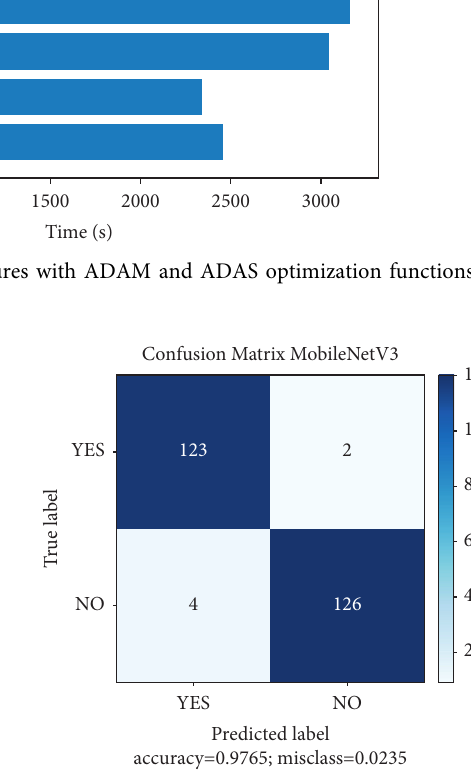
Figure 24: Accuracy evaluation matrix of MobileNetV3 network architecture using ADAS optimization algorithm via F1-score.